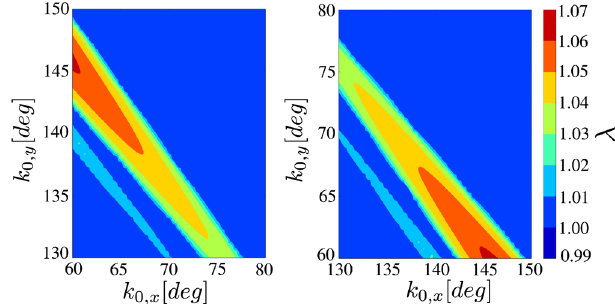
FIG. 8. Phase shifts of ϕ 1 ; 2 , ψ 1 ; 2 verses tune depression in x with fixed k 0 ;y ¼ 145 ° and varying k 0 ;x ¼ 40 ° (yellow), 50° (red), 60° (blue) and 70° (green).